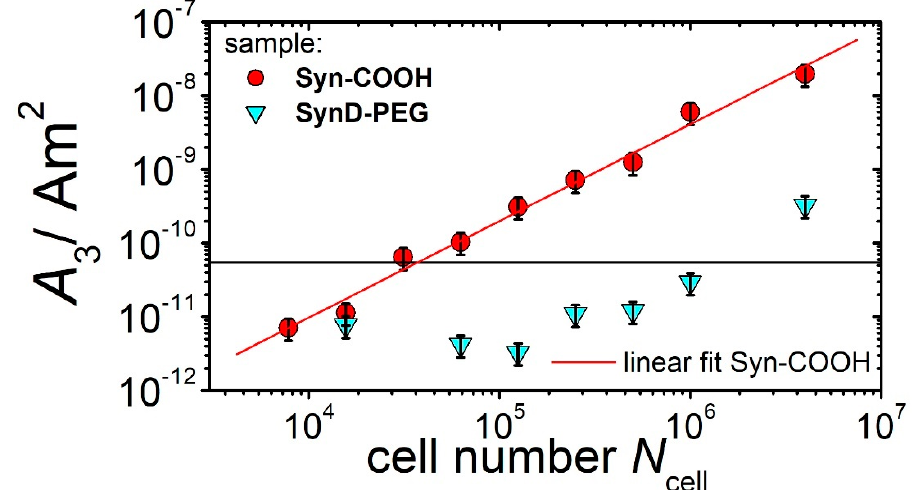
Figure 7. MPS signal amplitude ( A 3 ) as a function of cell number ( N cell ) (from 7800 to 4 × 10 6 THP − 1 monocytes), loaded with Syn-COOH (red circles) and SynD-PEG (blue triangles), and measured at B = 12 mT. The horizontal line represents with 5.5 × 10 − 11 Am 2 the MPS noise level (mean + threefold standard deviation of 40 blank measurements of A 3 ).